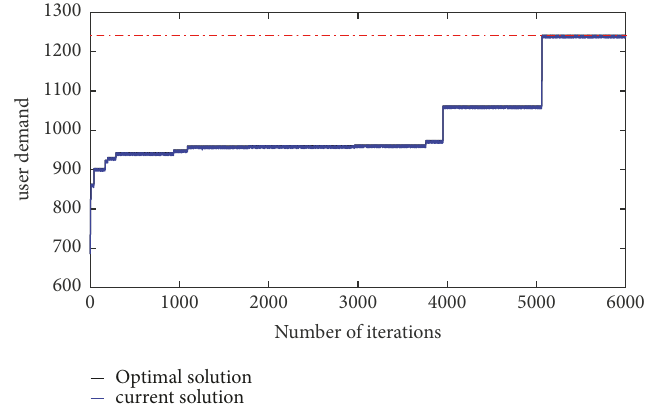
Figure 8: Diagram of algorithm convergence of Figure 6(b) of virtual